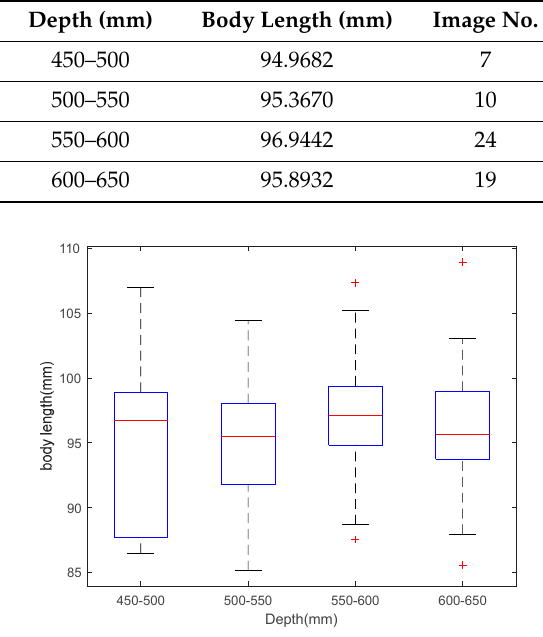
Table 1. The depth and corresponding body length.